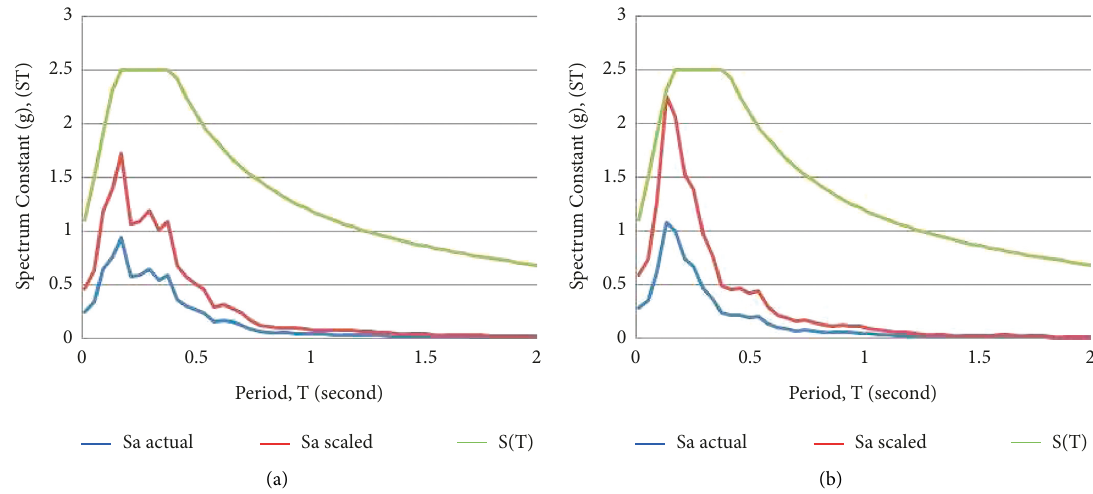
Figure 19: Evaluation of S(T) spectrum constants for (a) North-South (N-S) and (b) East-West (E-W) components of earthquake with epicenter at Kayseri-Kocasinan ( M D :